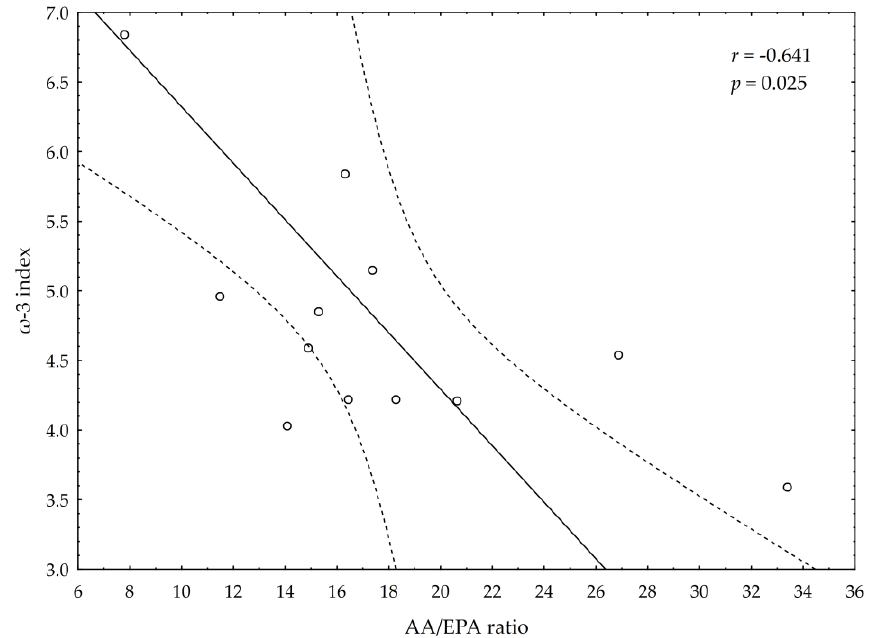
Figure 1. Correlation between omega-3 index ( ω -3 index) and AA/EPA ratio.